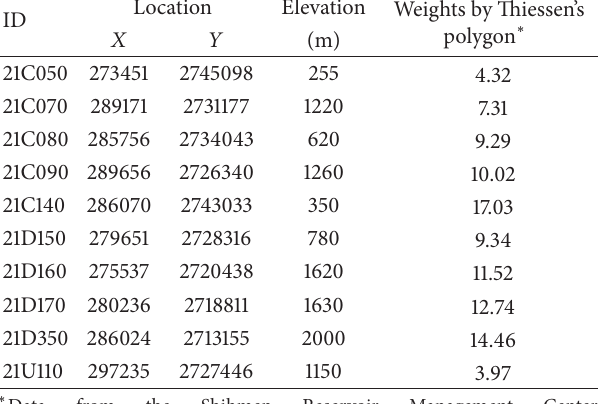
Table 3: Selected precipitation gauges with hourly data records and the corresponding weights of Thiessen’s polygon, 𝑊 𝑛 . The average rainfall of the Shihmen Reservoir catchment was calculated using Thiessen’s polygon method by